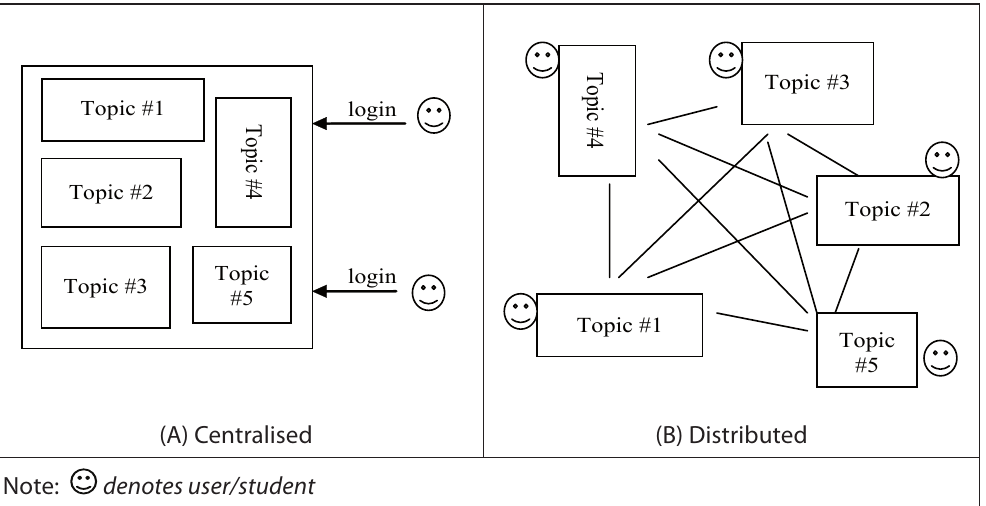
Figure 1 Centralised traditional learning approach (A) and distributed networked learning model